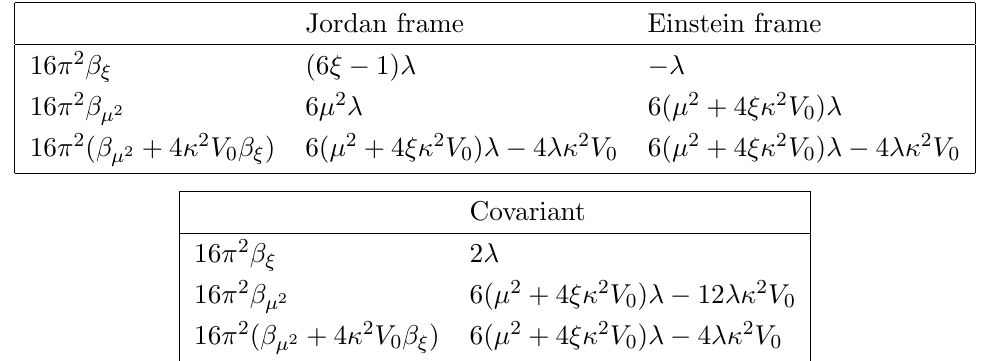
Table 1 . (cid:12) (cid:0) functions for the curvature coupling and the mass of a gravity coupled scalar (cid:12)eld at leading order for small (cid:20) 4 V 0 . The Jordan frame result has been calculated directly from the original action. The Einstein frame result is obtained by transforming the action to the Einstein frame. The covariant result uses a geodesic expansion on (cid:12)eld space and is independent of the frame used. The renormalisation group (cid:13)ow of (cid:22) 2 + 4 (cid:20) 2 V 0 (cid:24) is the same for each of these approaches.